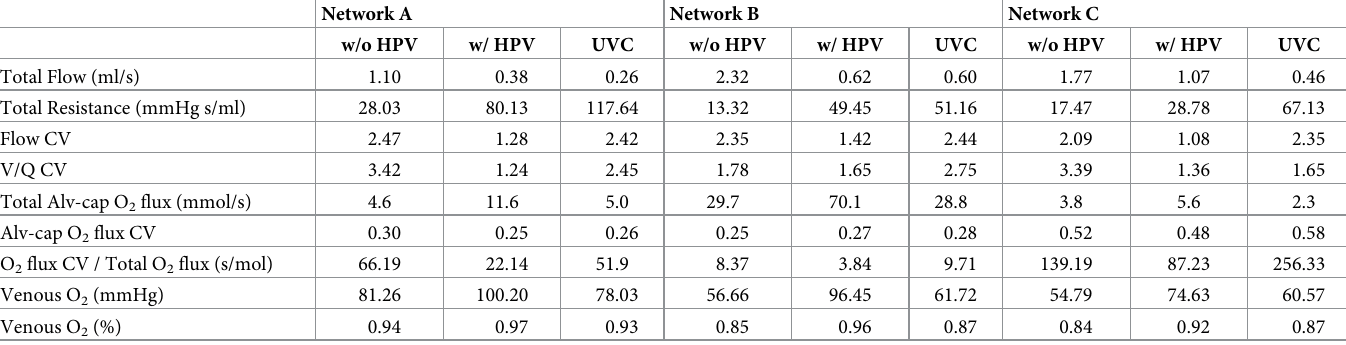
Table 5. Effect of HPV on regional flow, V/Q matching, and oxygenation. Model simulations were performed with uniform vasoconstriction (UVC), and with and with- out regulation by HPV. All simulations used a fixed 25 mmHg arterial-venous pressure drop. The top block summarizes how HPV and uniform vasoconstriction (UVC) affects the total flow through the organ, and the variability of blood flow, V/Q ratio by the Coefficient of Variation (CV = μ / σ ). The bottom block summarizes how HPV impacts the oxygenation in terms of the total alveolar-capillary oxygen mass flux, oxygen mass flux CV, oxygen mass flux normalized to total oxygen flux, venous oxygen tension, and venous oxyhemoglobin